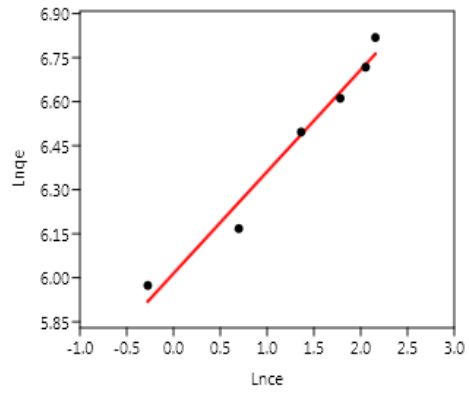
Figure 2. Langmuir adsorption isotherm for phosphate with chitosan-activated carbon nanocomposite